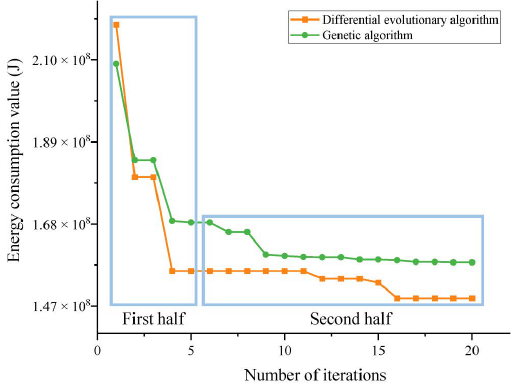
Figure 8. Comparison of the results of different algorithms.